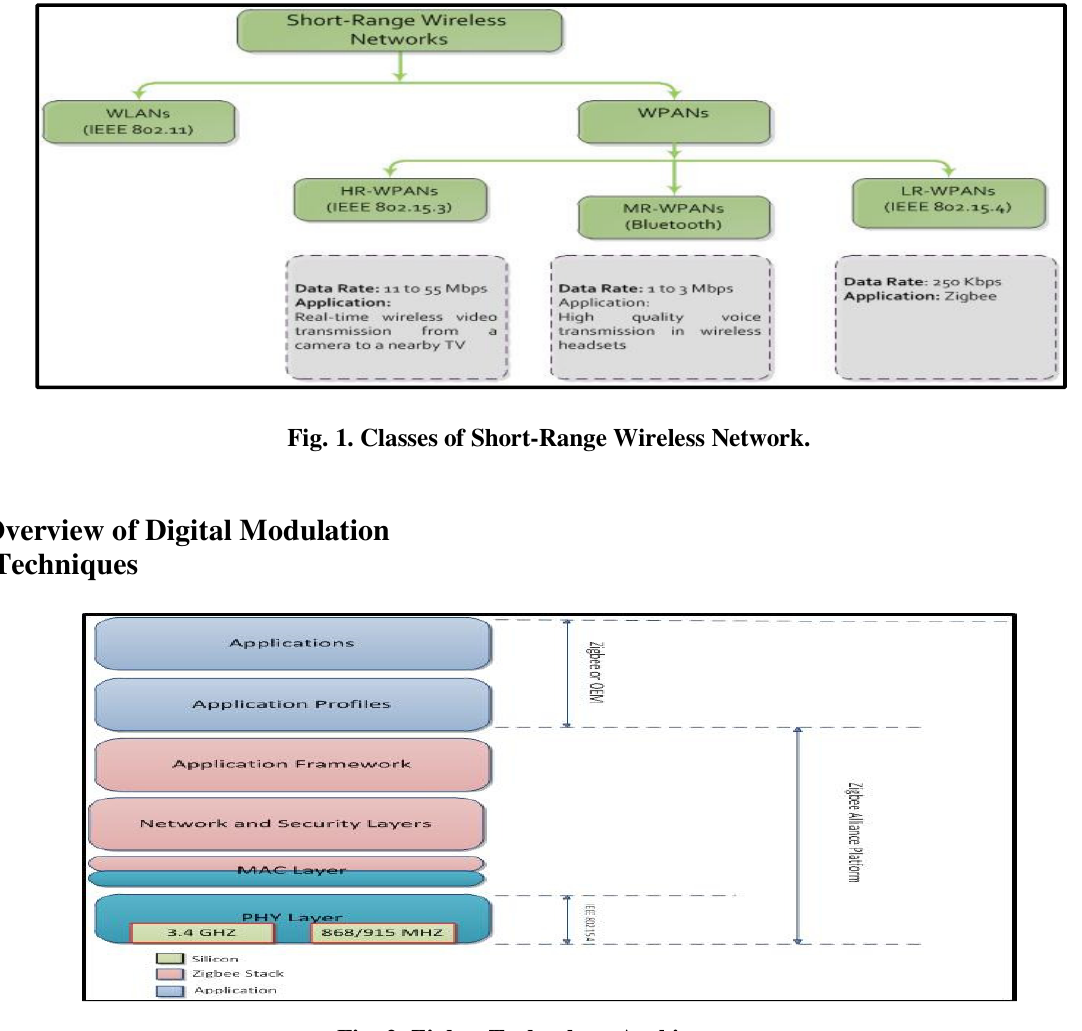
Figure 3 illustrates